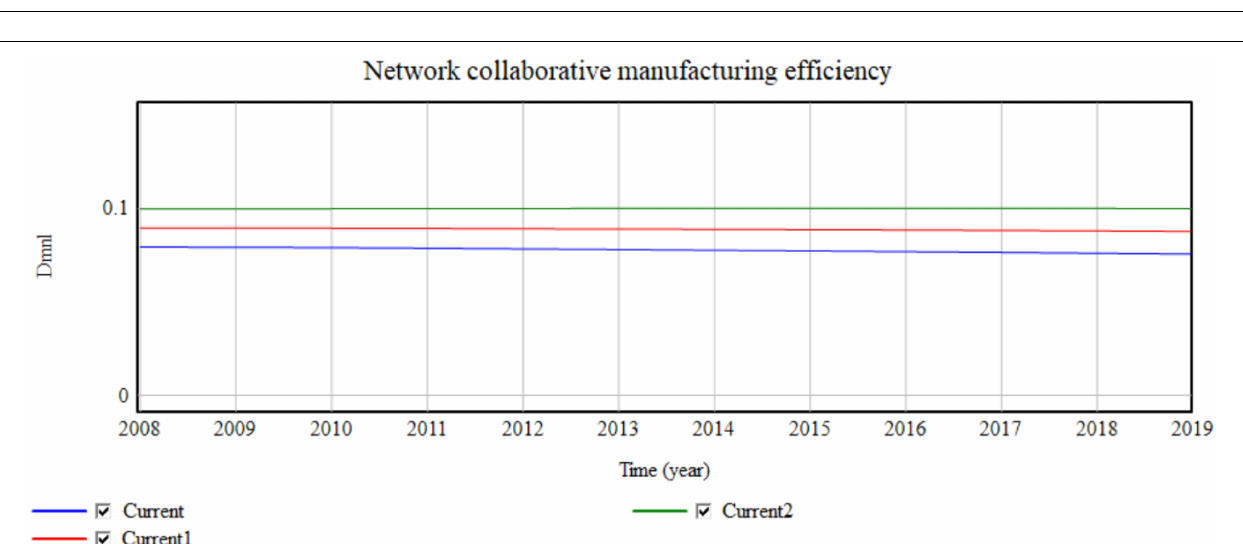
FIGURE 9 | Influence of micro science and technology innovation investment on business income.